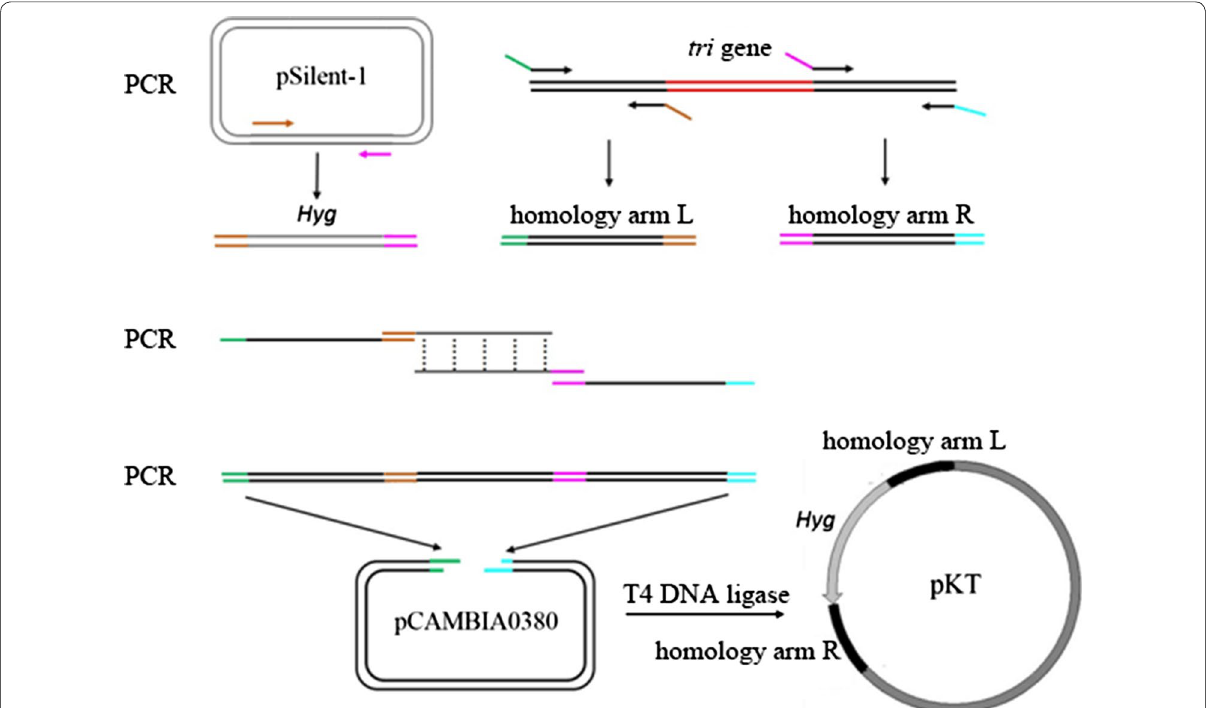
Fig. 1 Construction of the recombinant plasmid for gene knockout. First, using plasmid pSilent-1 as the template, hygromycin resistance gene was amplified by PCR. An approximately 1-kb upstream DNA fragment before the tri3, tri4 , and tir11 gene start codon and another 1-kb upstream DNA fragment downstream of the tri3 , tri4 , and tir11 gene stop codon were amplified to obtain homology L and R, respectively. Second, the above three linearized fragments were equimolarly mixed and cycled in a fusion PCR to generate a gene knockout fragment. Third, the corresponding gene knockout fragments were cloned into the Bst XI/ Xma I sites of pCAMBIA0380 to generate the corresponding vectors designated as pKT3, pKT4, and